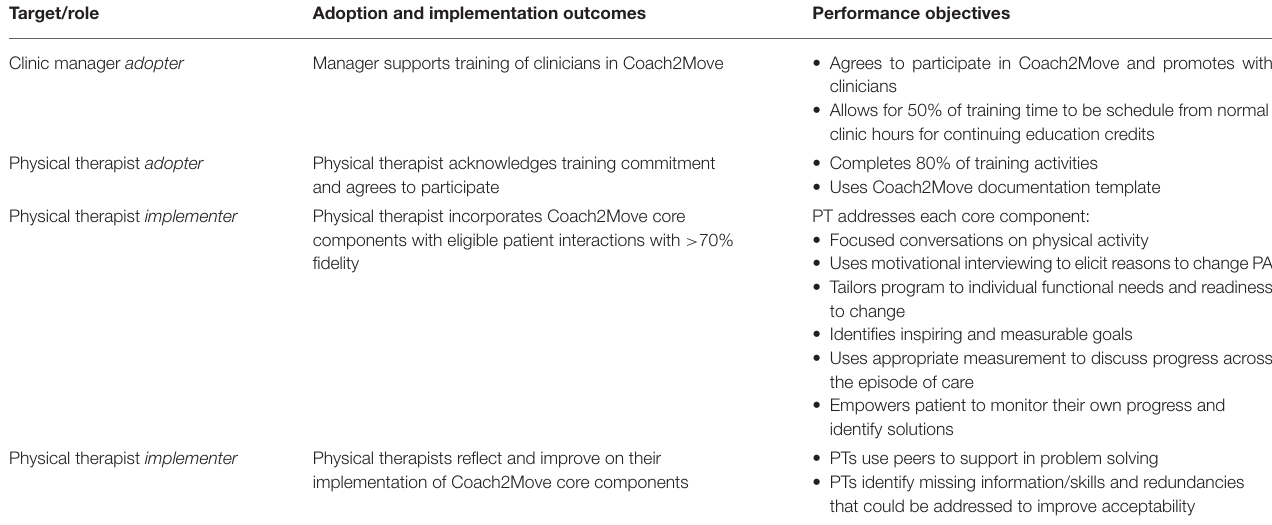
TABLE 3 | Implementation outcomes and performance